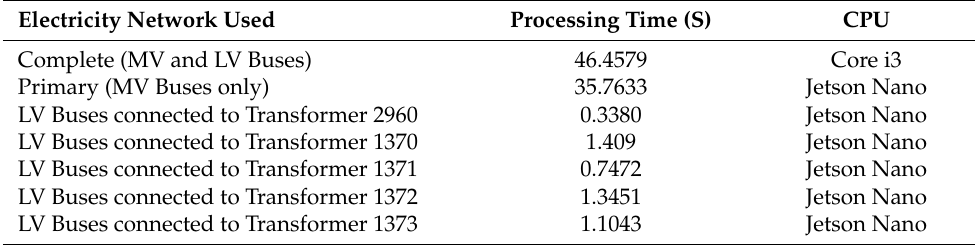
Table 2. Execution time of the state estimation